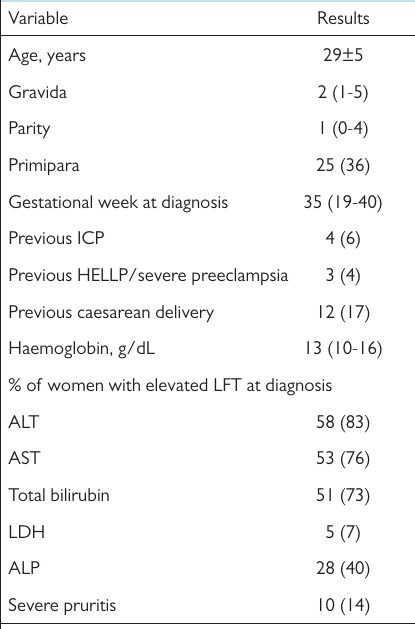
Table 1. Patient characteristics. Data are presented as n (%), mean ± standard deviation and median (minimum–maximum) wherever appropriate